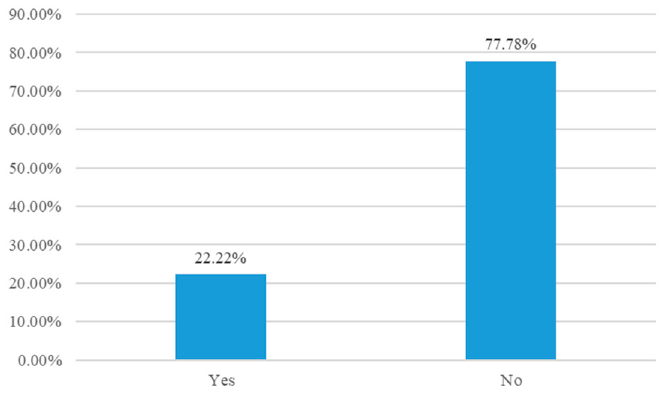
Figure 7. CICT trained by the administration .